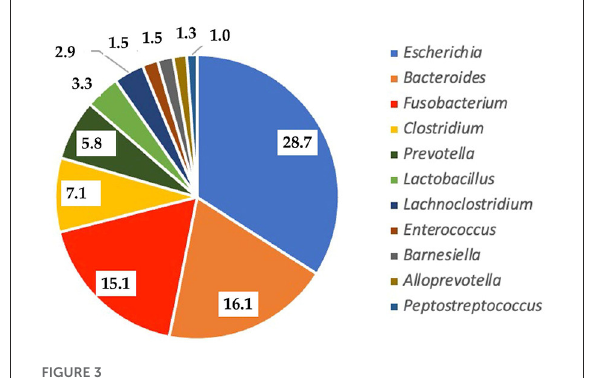
FIGURE3 Prevalence of bacterial genera in the gut of piglets before the